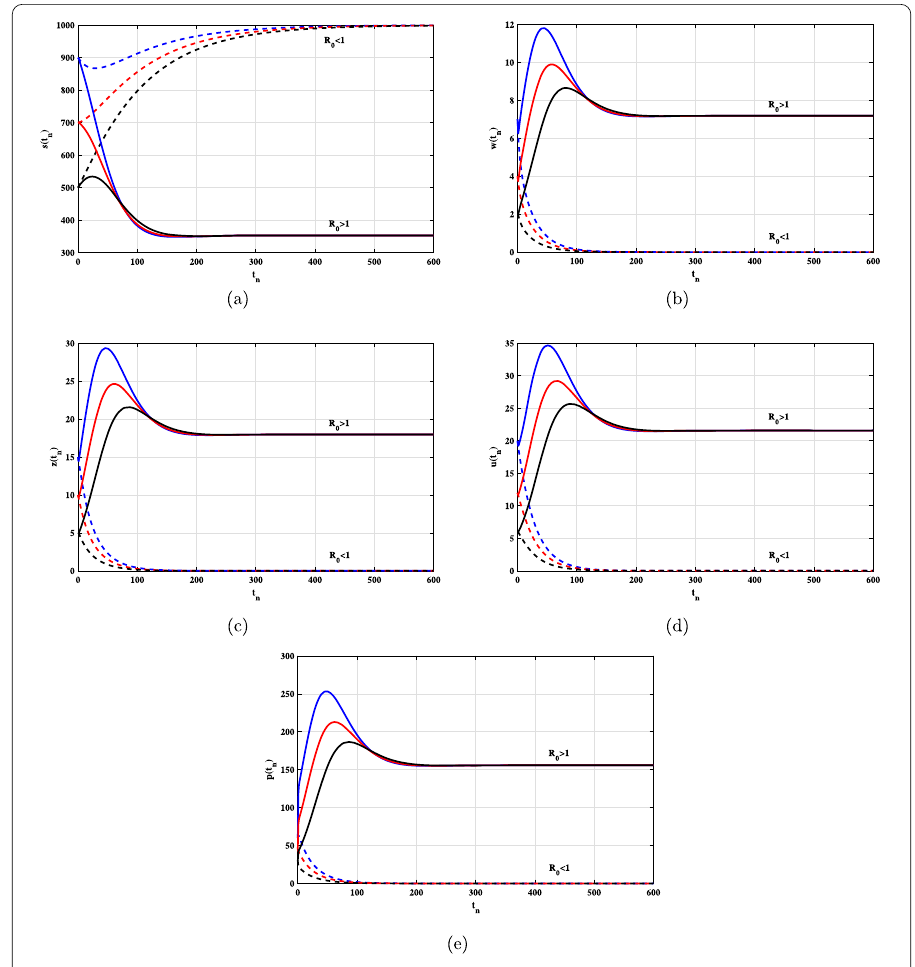
Figure 1 The simulation of trajectories of system (41)–(45) for Case (1)